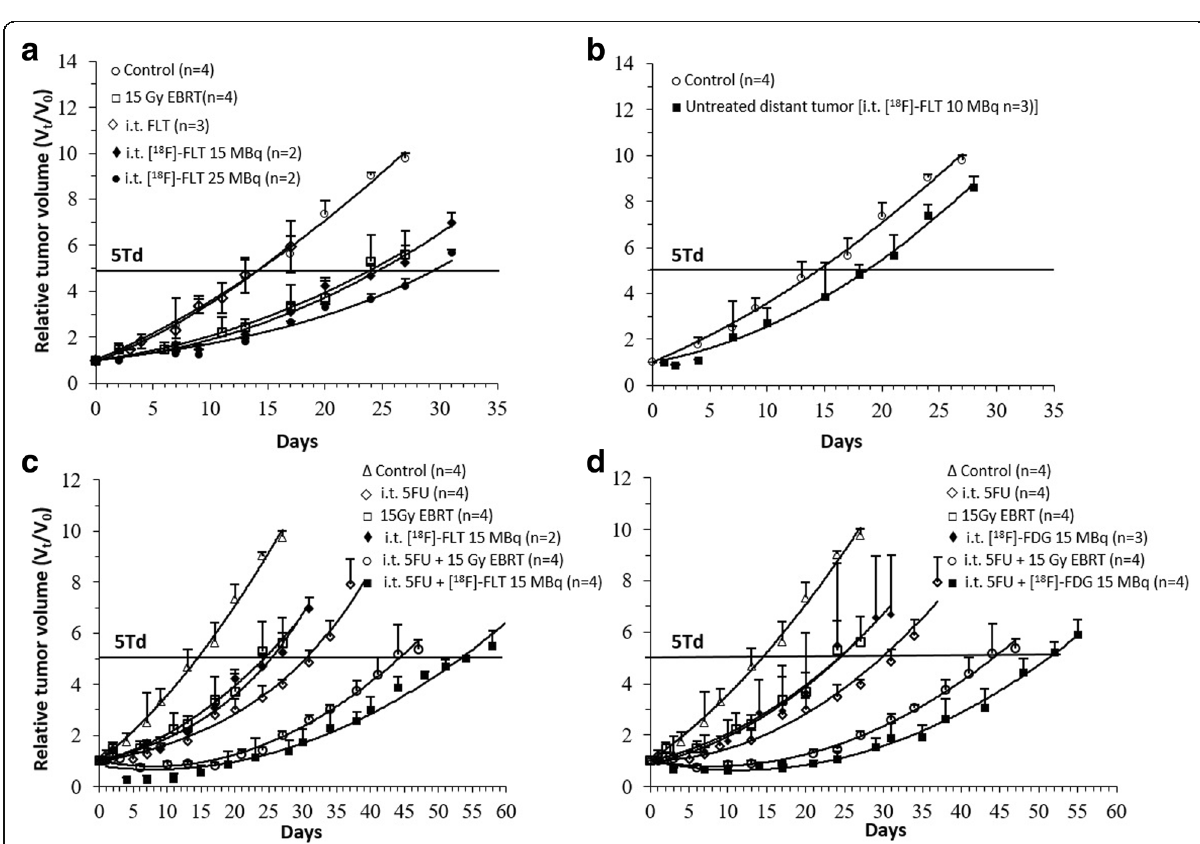
Fig. 6 Tumor growth profiles after different treatment conditions in HCT116 colorectal xenografts compared to controls without treatment. The curves are normalized to the tumor volume at the beginning of follow up with a 15 Gy of external radiation and with different activities of i.t. injected 18 F-FLT, b contralateral tumor after i.t. injected 18 F-FLT, c combined treatment of i.t. 5FU and i.t. 18 F-FLT or 15 Gy EBRT, and d combined treatment of i.t. 5FU and i.t. 18 F-FDG or 15 Gy EBRT . The error bars represent the standard deviation on the mean for two to four